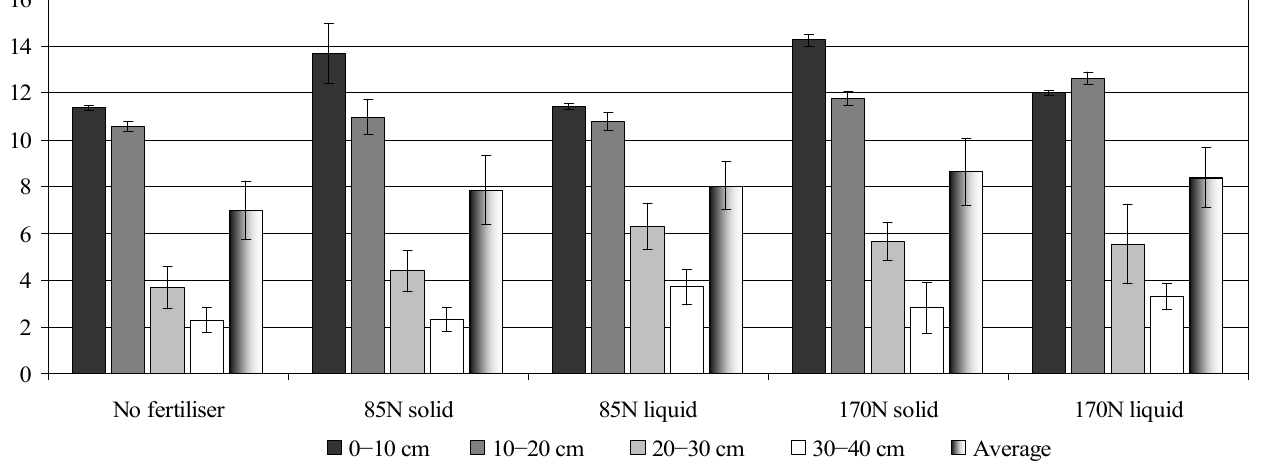
Figure 2. SOC content in the crop rotation field in Fluvisol, 2019.